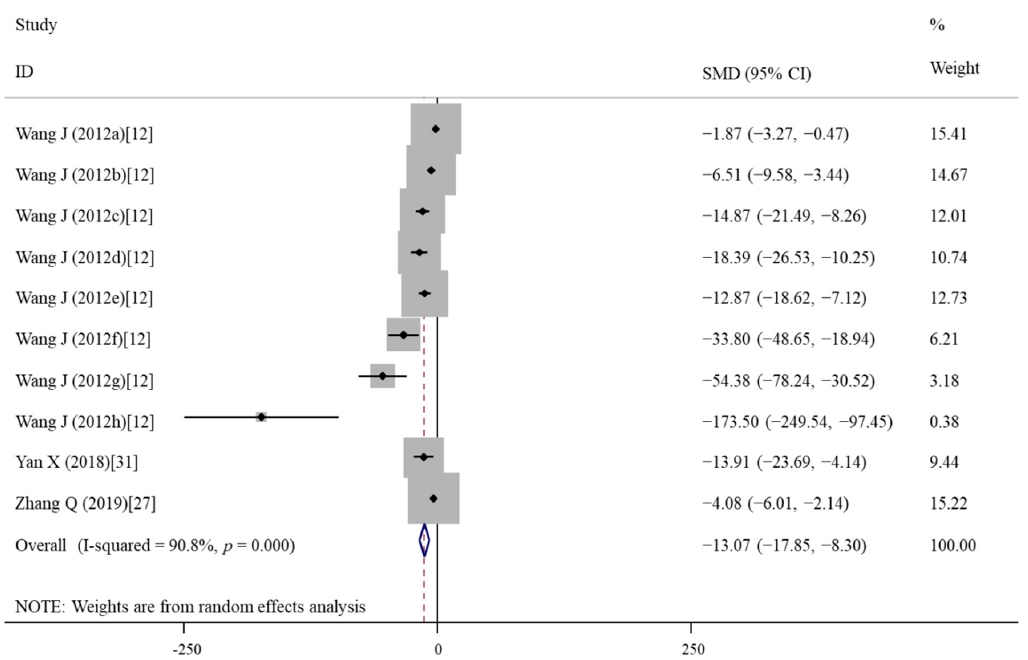
Figure 4. Forest plots showing the protective effects of vitamin E on ROS levels of cells compared with the nanomaterial exposure group. a, b, c, d of the study of Wang et al. represent treatment with 50, 500, 1000, 2000 μ M of vitamin E for 24 h; e, f, g, h of the study of Wang et al. represent treatment with 50, 500, 1000, 2000 μ M of vitamin E for 48 h. ROS, reactive oxygen species; SMD, standardized mean difference; CI, confidence interval. [12,27,31]